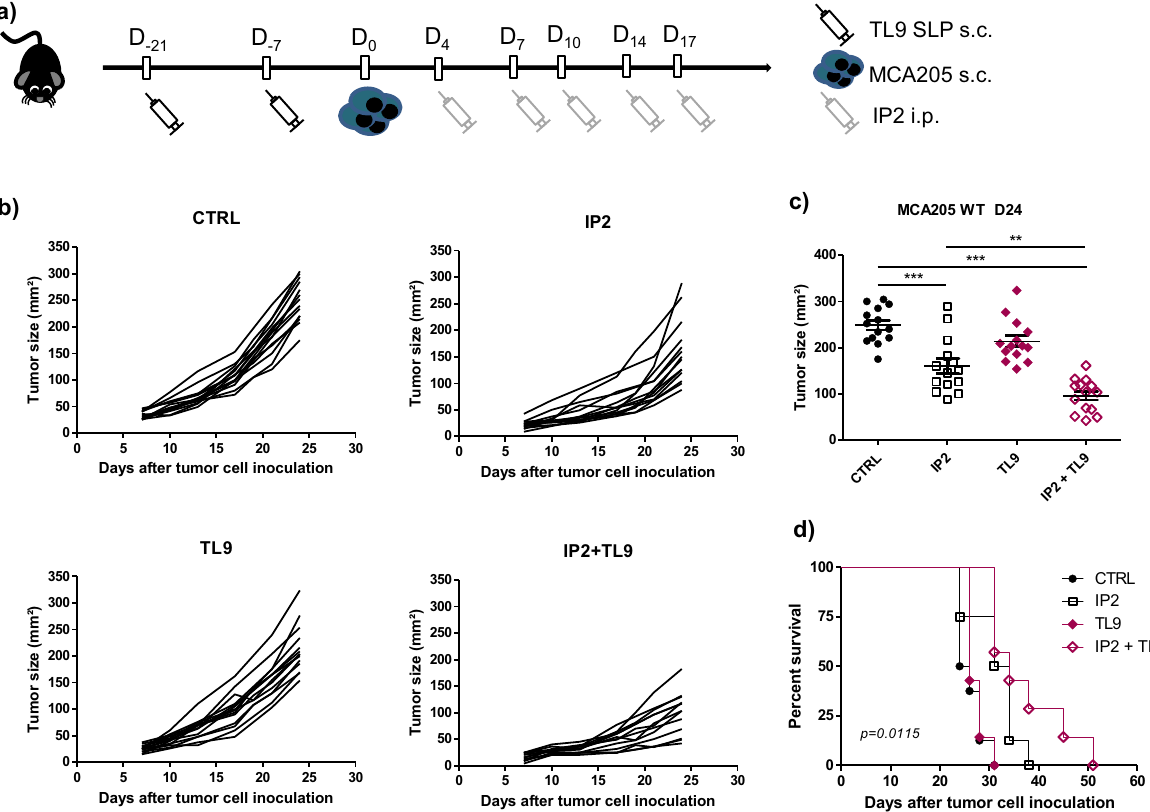
Fig. 6 IP2 treatment and a prophylactic cancer vaccine targeting the nischarin-derived epitope synergize to inhibit tumor growth. a Experimental setting for the evaluation of the antitumor activity of IP2 in combination with the prophylactic TL9 SLP vaccine. b Individual tumor growth kinetics and ( c ) tumor size at killing of MCA205 fi brosarcoma subcutaneously inoculated into the right fl ank of immunocompetent C57BL/6 mice previously vaccinated with the TL9 SLP and thereafter treated with 24 mg/kg of IP2 from tumor cell inoculation. d Kaplan – Meier survival curves of MCA205 fi brosarcoma- bearing immunocompetent C57BL/6 mice vaccinated in a prophylactic setting with the TL9 SLP and thereafter treated with 24 mg/kg of IP2 from tumor cell inoculation. Log-rank (Mantel – Cox) test was performed for survival analysis. ** P < 0.01, *** P < 0.001 (One-way